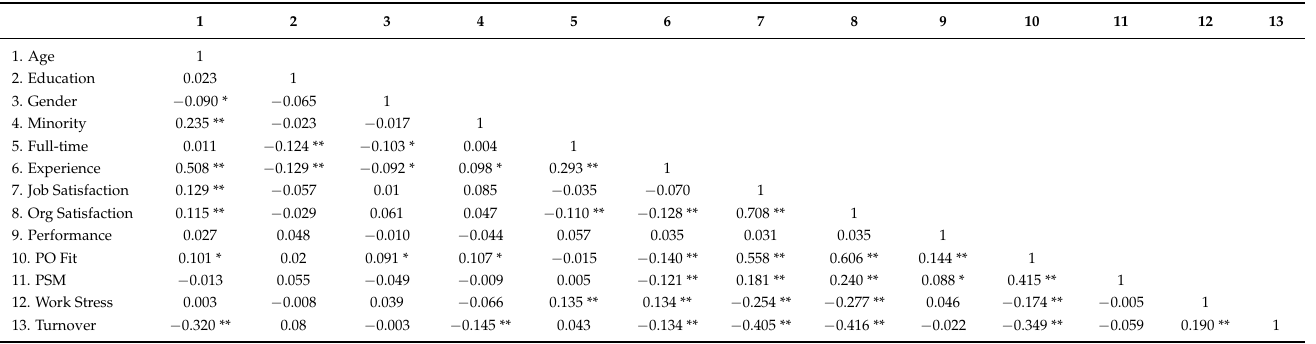
Table 4. Bivariate correlations among study